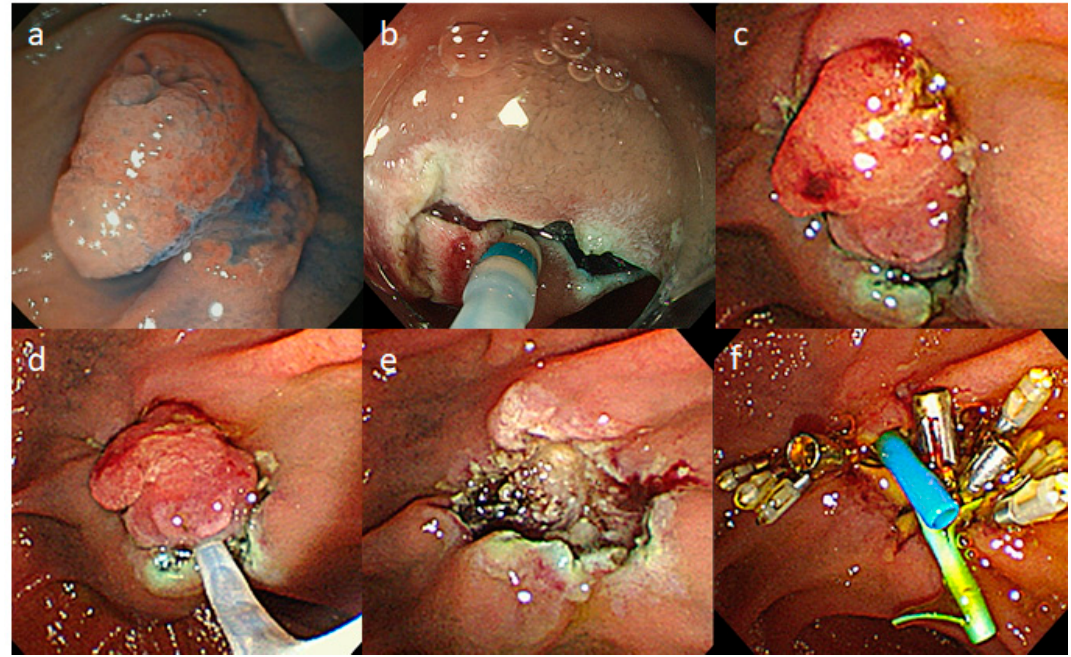
Figure 1. Endoscopic papillectomy with hybrid endoscopic submucosal dissection. Figure legend: ( a ): The ampullary adenoma with the diameter of 20 mm; ( b ): A circumferential incision was made after the local injection of sodium hyaluronate solution; ( c ): The submucosal dissection was continued until as large as possible; ( d ): The tumor was grasped along the excision line; ( e ): The tumor was resected using a standard loop snare; ( f ): Both biliary and pancreatic stents were placed and the ulcer was closed using clips.